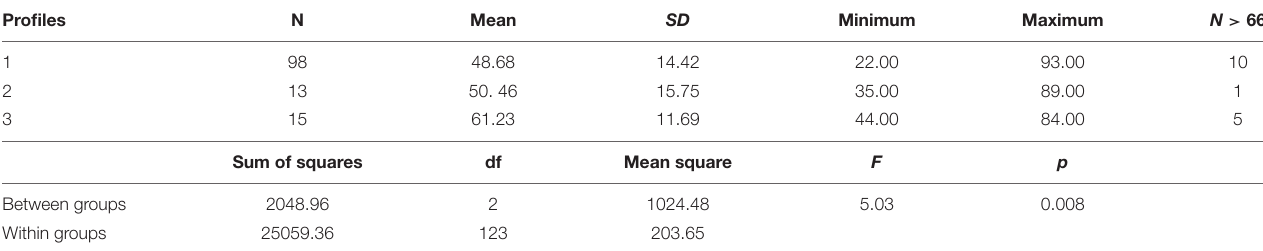
FIGURE 1 | Post hoc multiple comparisons tests (Tamhane’s T2 and LSD) using the five scales of the SRS. P1 ( N = 98); P2 ( N = 13); P3 ( N = 15); Anal (Risky anal sex); Acts (Risky sex acts); Impulsive (Impulsive sexual behaviors); Intent (Intent to engage in sexual behaviors); Partner (Sexual risk taking with uncommitted partners); ∗ p < 0.05 ; ∗∗ p < 0.01. Tamhane’s T2 tests were used when the assumption of homoscedasticity was not met. TABLE 3 | ANOVA with the three profiles as independent variables and borderline personality features as the dependent